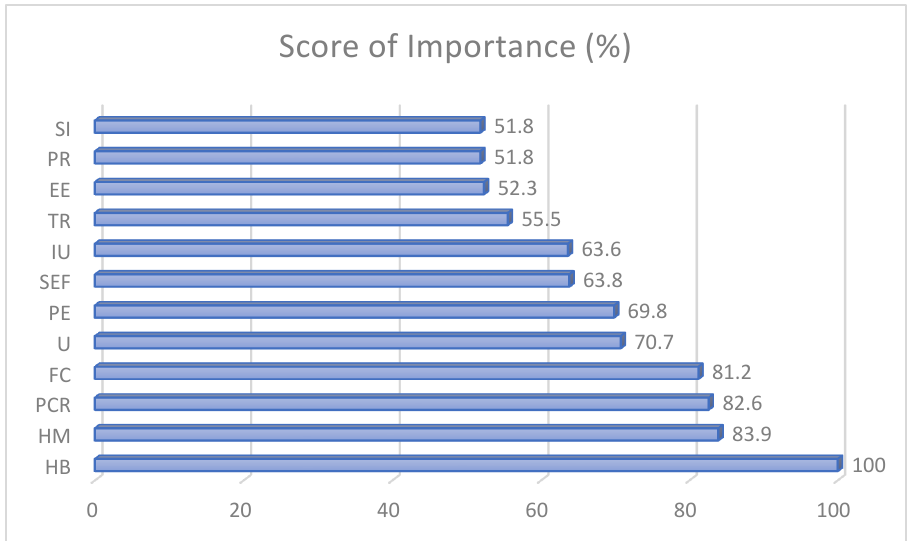
Figure 9. Score of Importance.